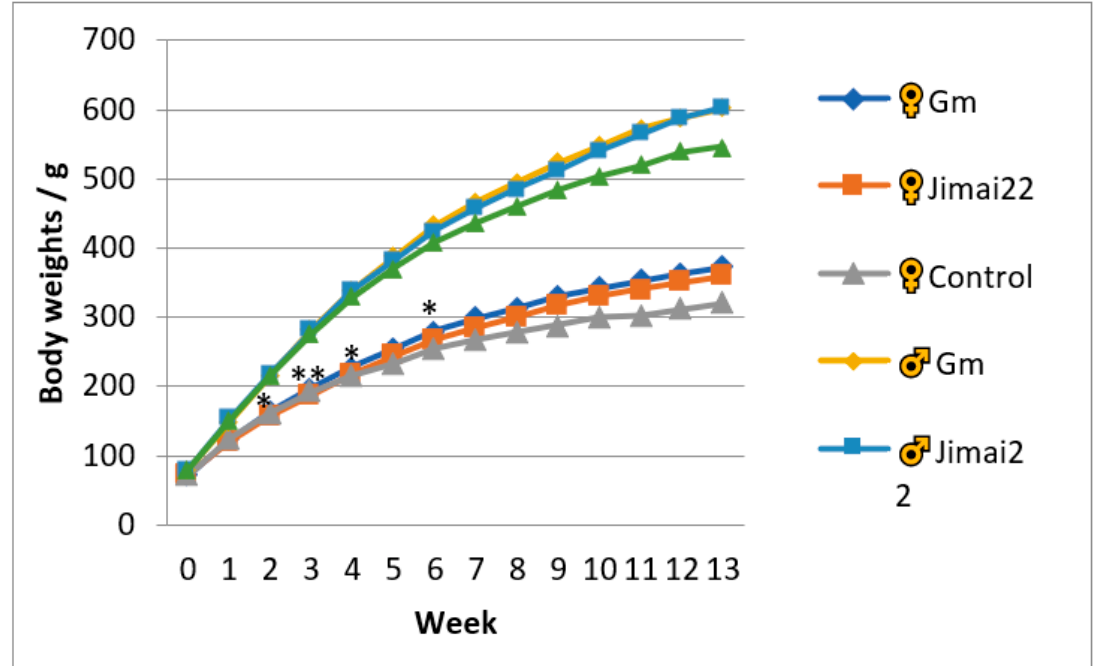
Figure 1. Weekly body weights of female and male animals in three groups. * represents p < 0.05 compared with Jimai22 group; ** represents p < 0.01 compared with Jimai22